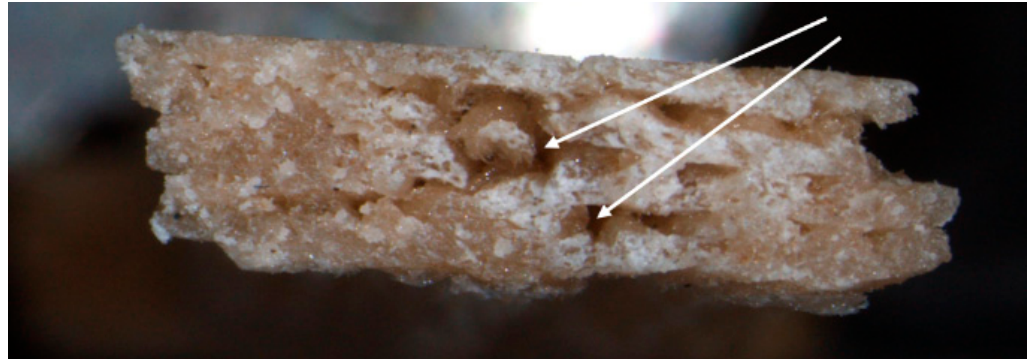
Figure 5. 30 wt % harakeke fracture surface with arrows depicting voids.